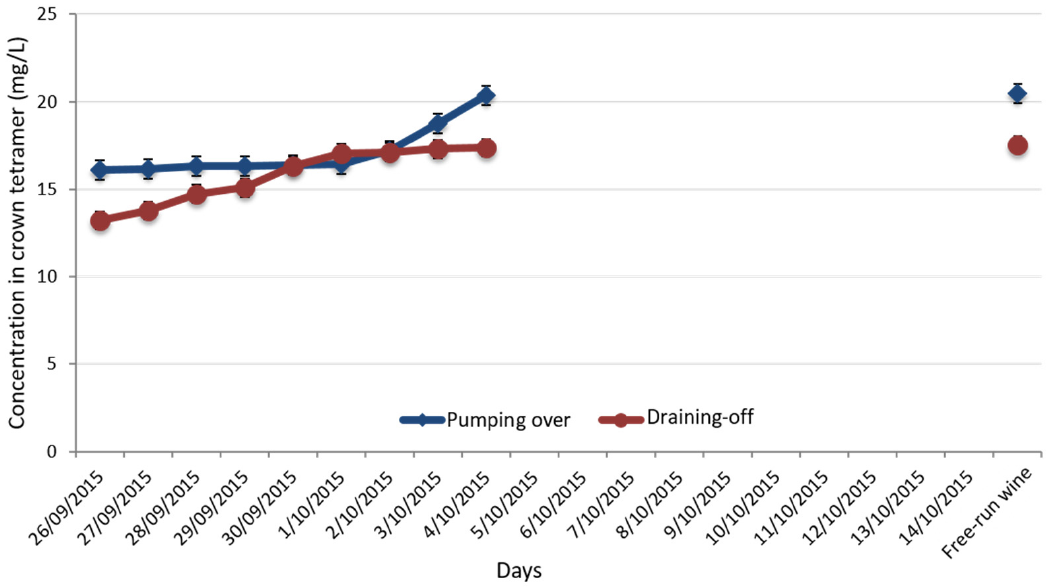
Figure 3. Impact of the extraction process on the crown procyanidins’ tetramer concentration.